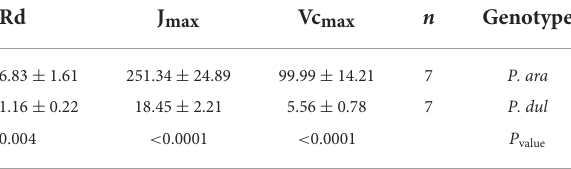
TABLE 1 Photosynthetic parameters of P. arabica ( P. ara ) and P. dulcis ( P. dul ) stems derived from CO 2 assimilation vs. internal CO 2 concentration data (A/ C i